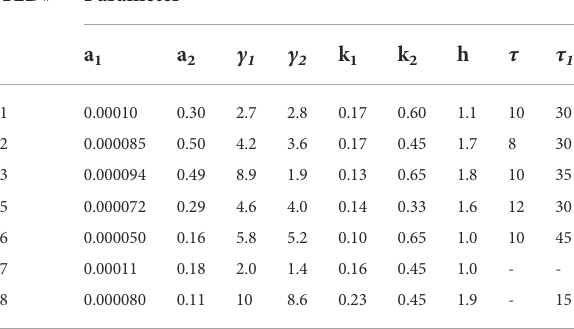
TABLE 2 Parameters obtained from fi tting the coupled Model 1 to patients with T2D.